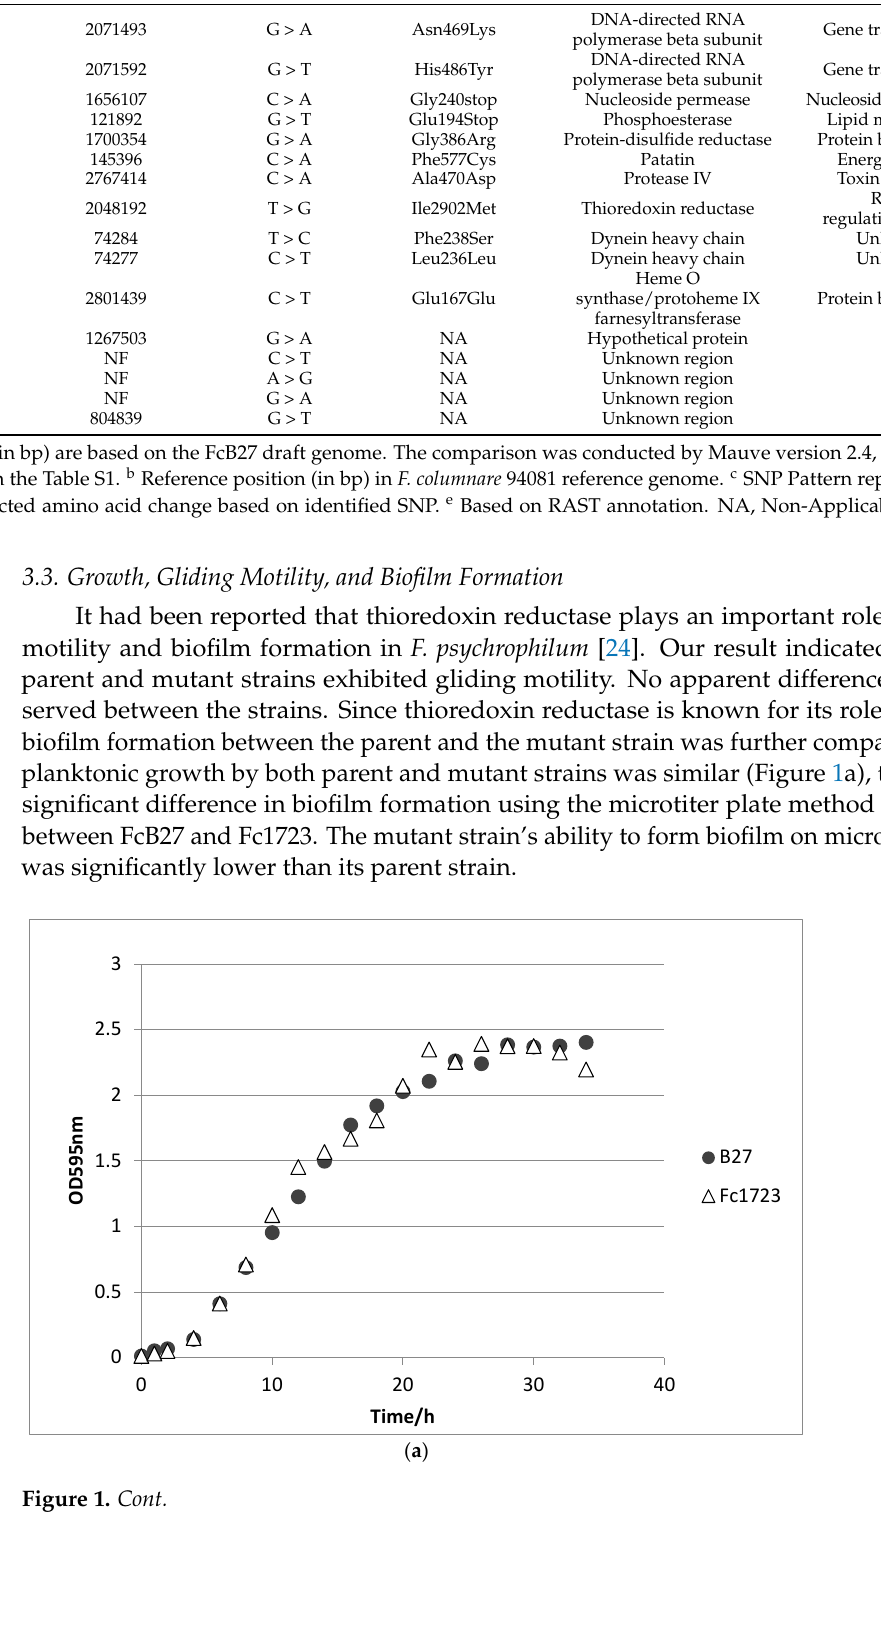
Table 1. Analysis of single nucleotide polymorphisms (SNPs) compared between vaccine strain and parent strain. SNP Contig